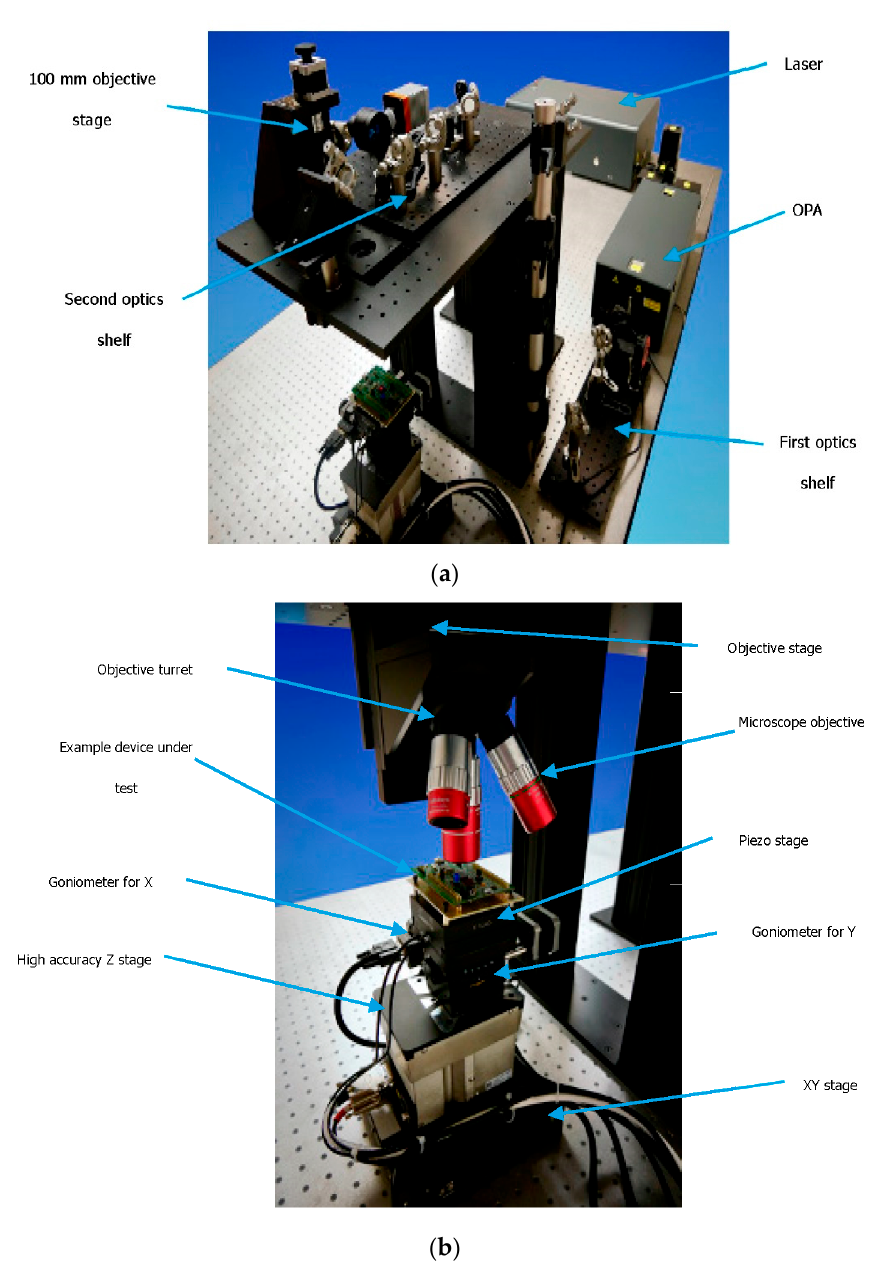
Figure 4. Pulsed laser test equipment and loading platform. ( a ) TPA pulsed laser SEE equipment; ( b ) DUT loading